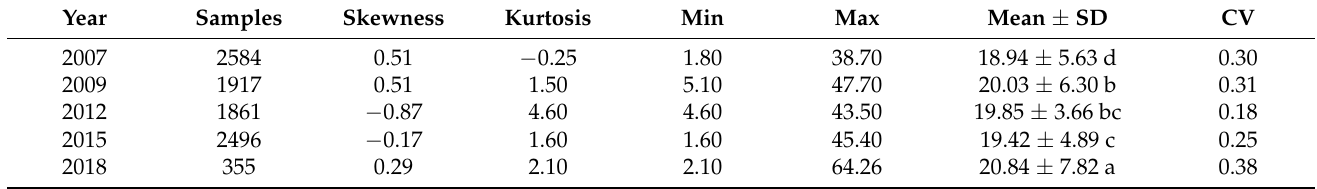
Table 3. The statistical description of soil organic matter (g kg − 1 ) in 2007, 2009, 2012, 2015, and 2018 in Lishu